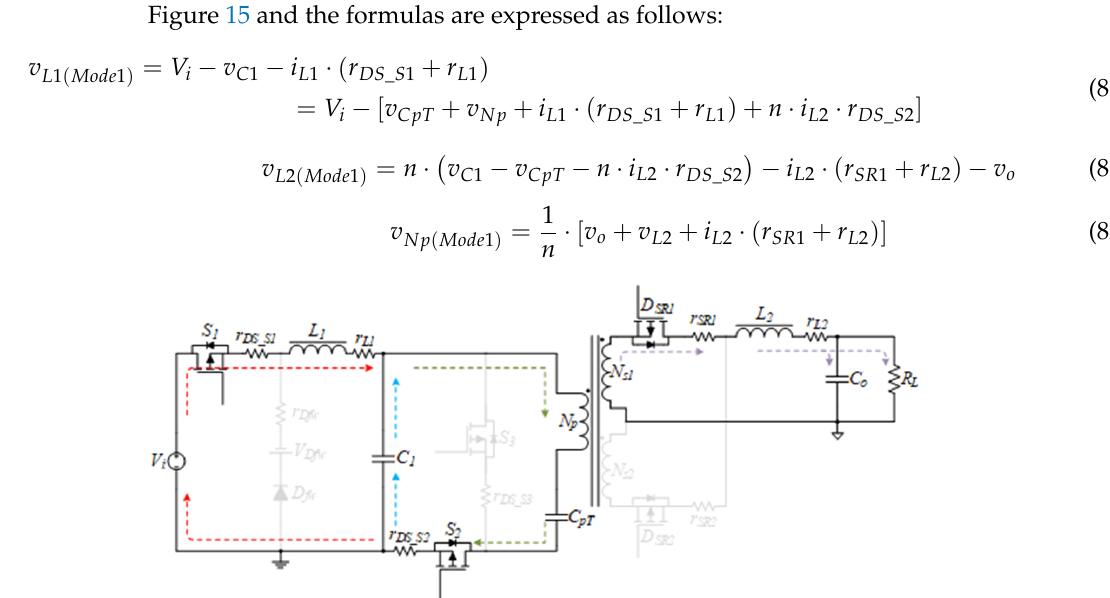
Figure 17. Equivalent circuit operating during [0.5 T , (0.5 + D ) T ]. Mode 4 [(0.5+ D ) T , T ] Similar to the Mode 2 state, the main switches S 1 , S 2 and S 3 are all in the turned-off state. The inductor L 1 keeps releasing energy to the capacitor C 1 and the output inductor L 2 changes into the freewheeling state, releasing energy to the output load R L . The equiv- alent circuit is shown in Figure 18 and the formulas are expressed as follows:  () = −[  +   +   ∙ (  +   )]